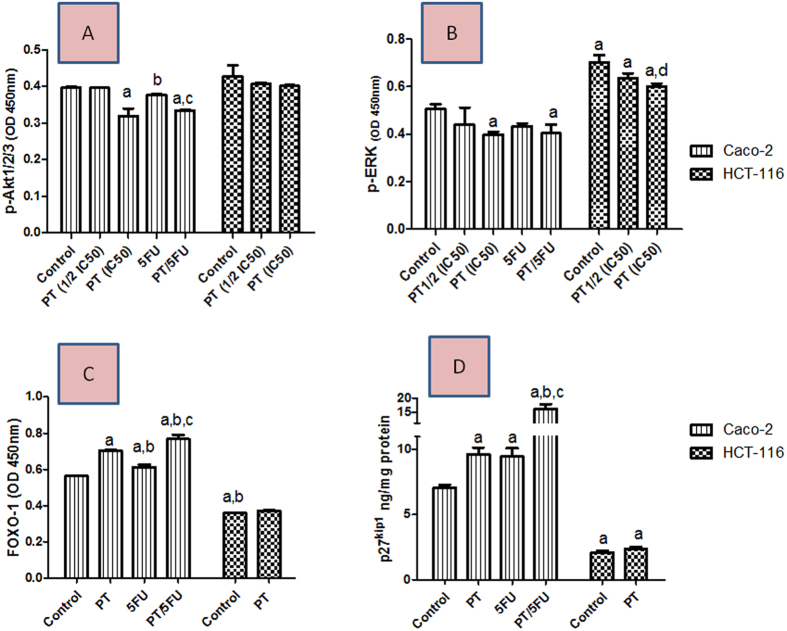
Effect of PT on Akt1/2/3 activation (A), ERK1/2 (B), FOXO1 (C) and p27kip1(D) expression in Caco-2 and HCT-116 colon cancer cell lines using ELISA assay. Data are means ± SD (n = 3). The experiment was done in triplicates. a indicates significant difference from Caco-2 control at p < 0.05. b indicates significant difference from Caco-2/PT group at p < 0.05. c indicates significant difference from Caco-2/5-FU group at p < 0.05. d indicates significant difference from HCT-116 control at p < 0.05.